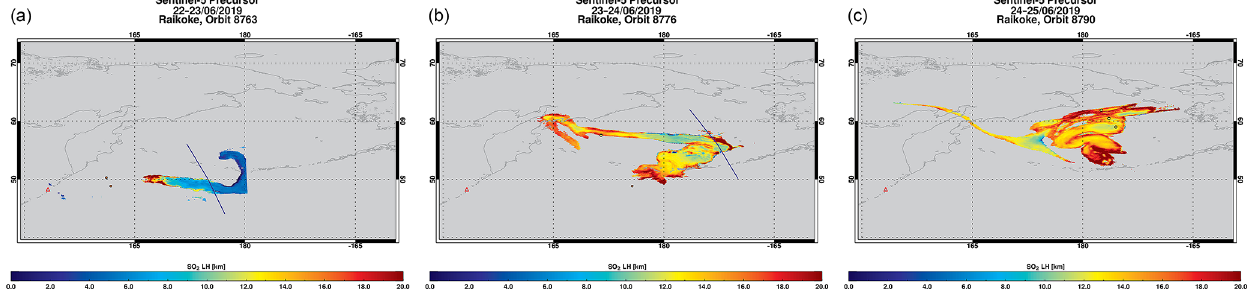
Figure 14. SO 2 LH retrieved for the TROPOMI orbits shown in Fig. 13. Only pixels with SO 2 VCDs greater than or equal to 20DU are shown. Colored circles indicate the MLS/Aura SO 2 profile peak height for the results shown in Fig. 15. The blue lines indicate the CALIPSO ground track for the results shown in Fig. 16.